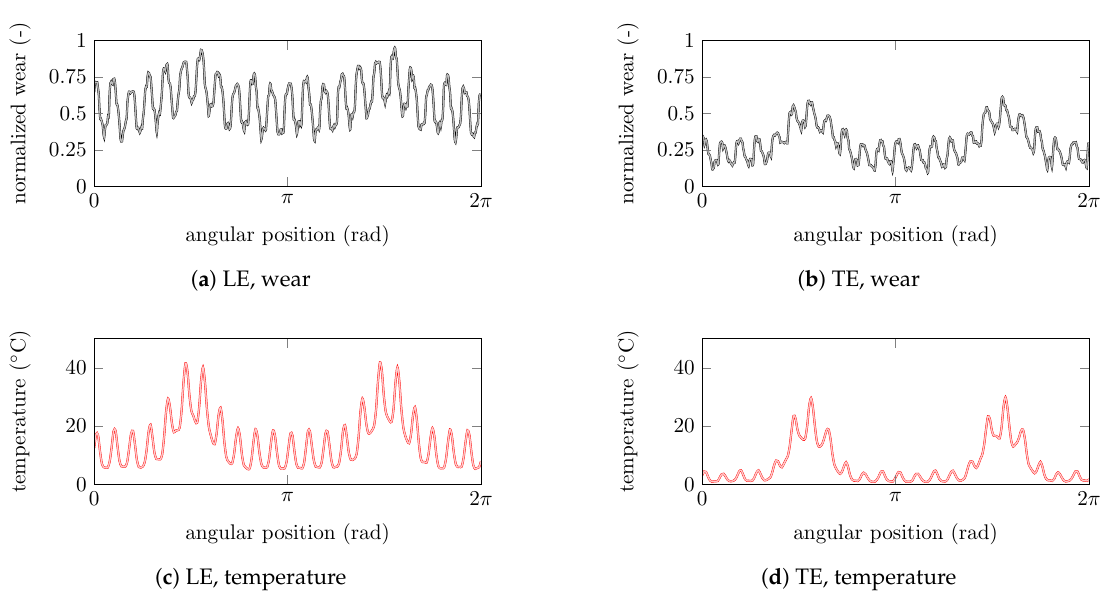
Figure 6. Convergence analysis of the wear and temperature profiles at the end of the simulation at the leading and trailing edge with R t : R t = 1 ( / ), R t = 500 ( / ), R t = 1000 ( / ), R t = 5000 ( /